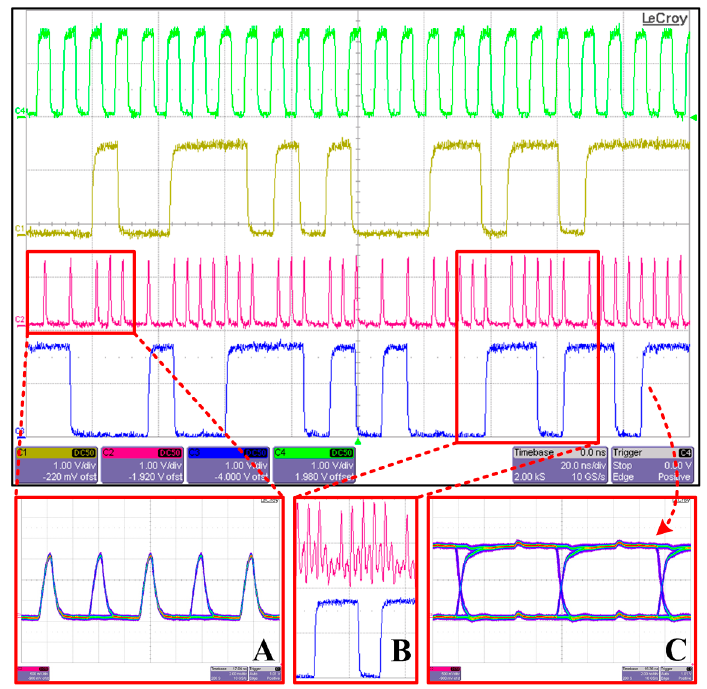
Figure 6. Main signals related to the transmitter and the receiver blocks. From top to bottom: CLK T (green), S T ( t ) (yellow), U T ( t ) (purple), S R ( t ) (blue). In the insets: ( A ) multiple acquisitions of U T ( t ) for the evaluation of the amplitude and phase jitters; ( B ) U R ( t ) and the related S R ( t ); ( C ) the eye diagram of S R ( t ).